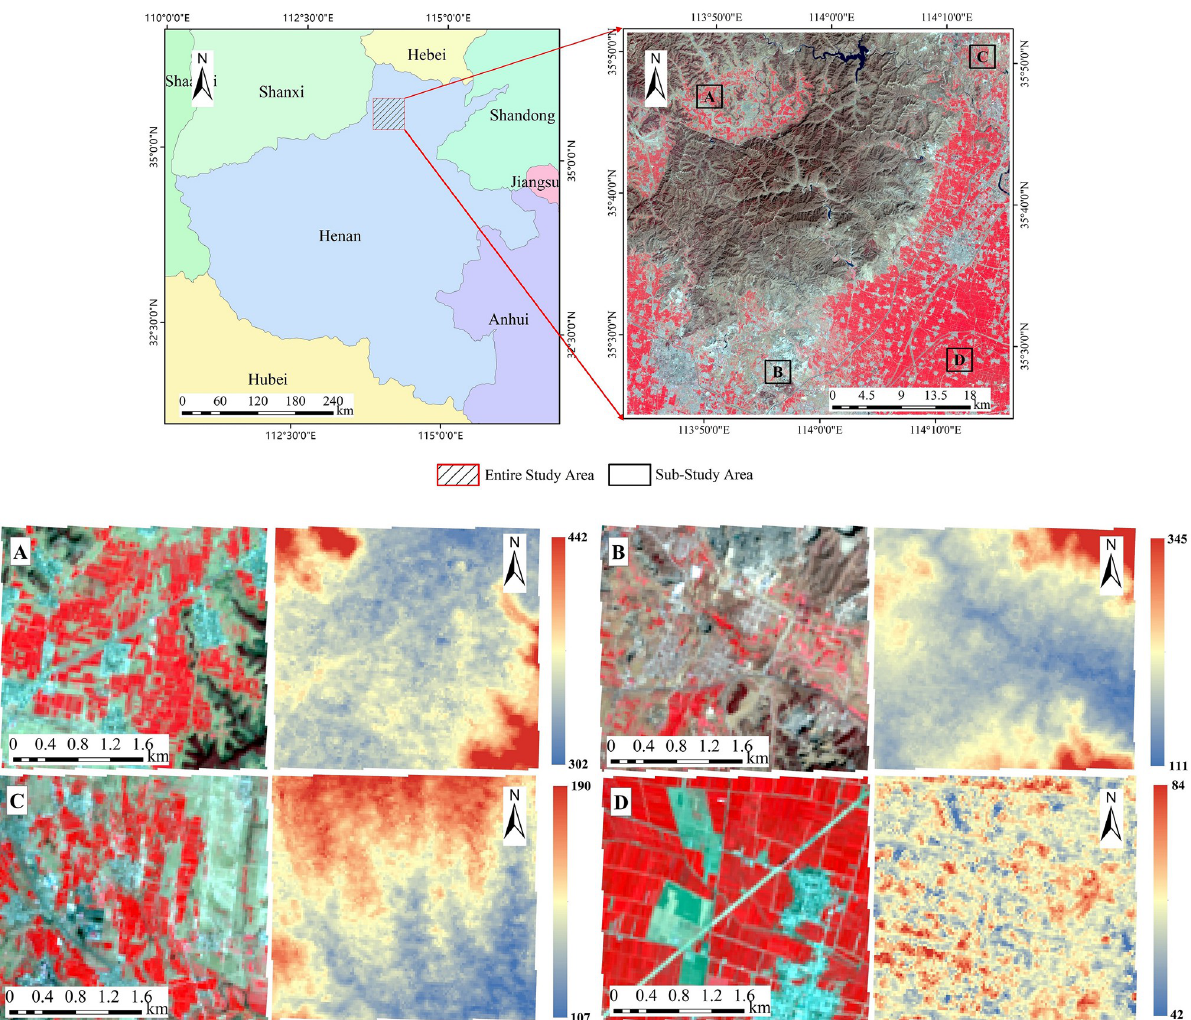
Fig 1. Study area. Note: The pseudo-color image (R: NIR, G: Red, B: Green) presented in the figure is a Landsat-8 image acquired on March 19, 2020 (https://landsat.visibleearth.nasa.gov/), this Landsat image is similar but not identical to the original image used in the study. The digital elevation image is an advanced spaceborne thermal emission and reflection radiometer (ASTER) global digital elevation model (GDEM) Version 3 image (https:// earthdata.nasa.gov/learn/articles/new-aster-gdem), and the digital elevation imagery legend is in